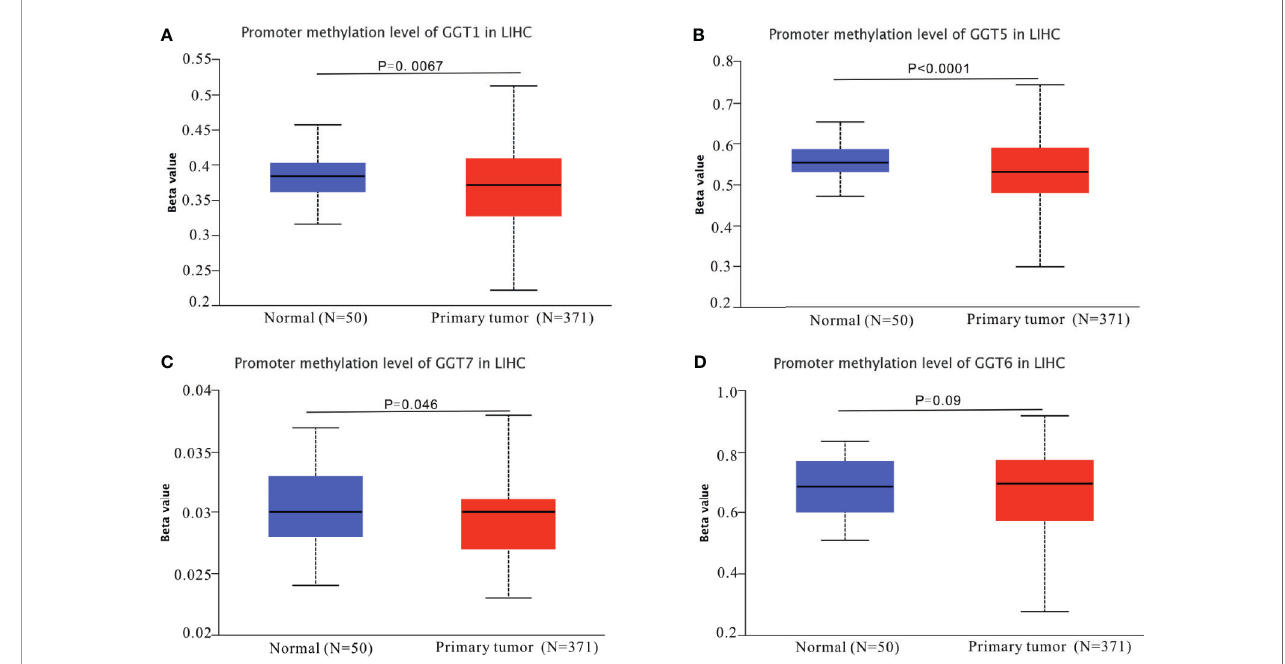
FIGURE 5 | DNA methylation patterns of GGT family genes in HCC tumors and normal controls. DNA methylation of GGT1 (A) , GGT5 (B) , and GGT7 (C) was signi fi cantly higher in normal tissues than the corresponding HCC specimens, with the exception of GGT6 (D)